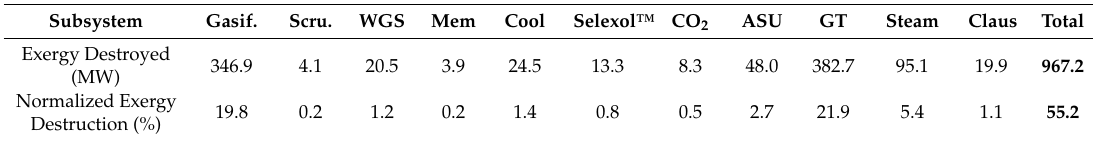
Table 10. Carbon Dioxide Membrane Model results, assigning exergy destruction associated with heat transfer to/from the Steam subsystem to the non-Steam subsystem.